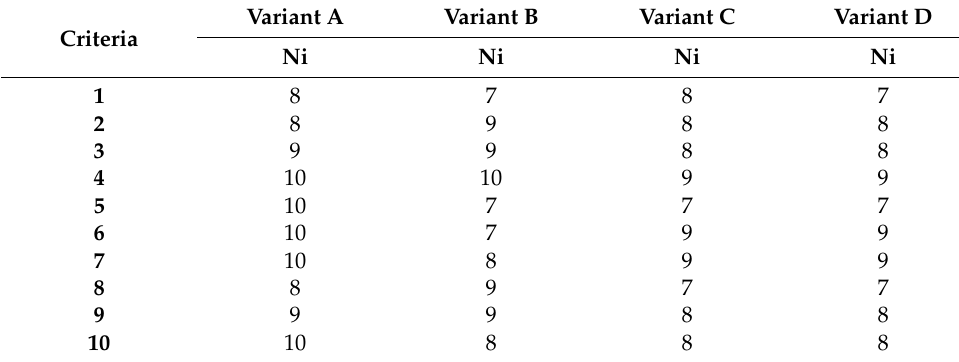
Table 5. Notes (Ni) offered to the established variants.